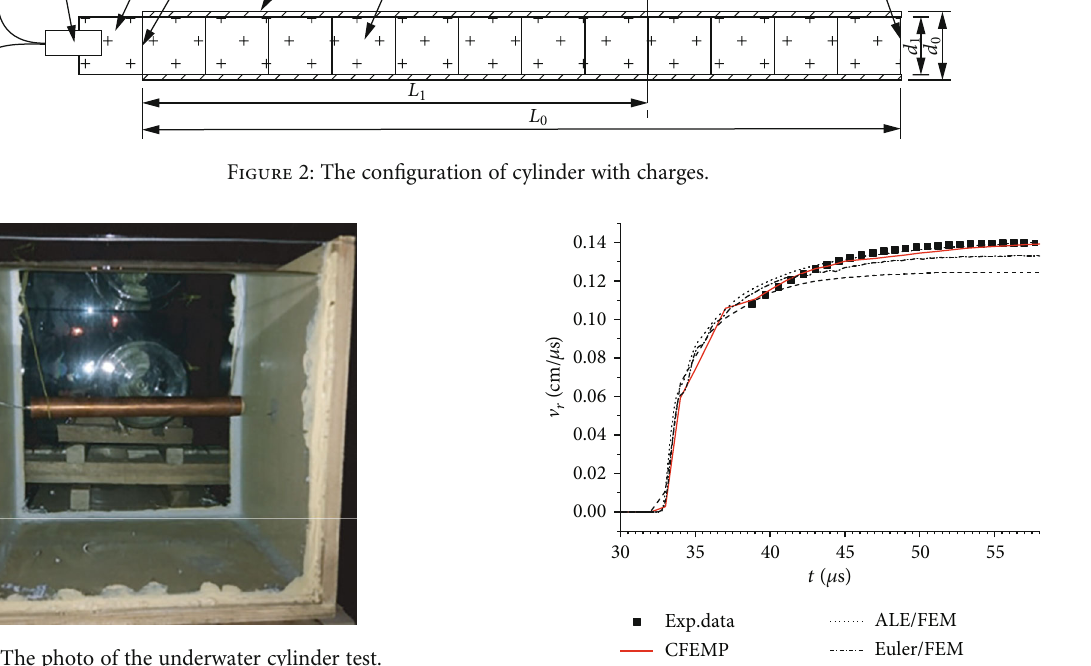
Figure 3: The photo of the underwater cylinder test.